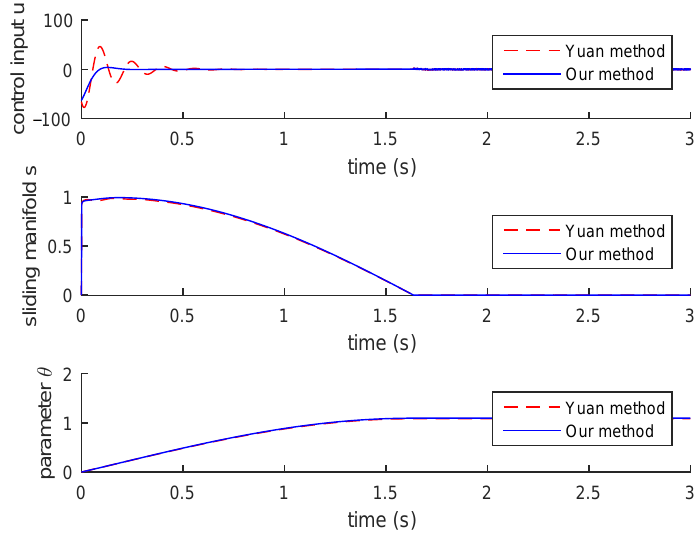
Figure 2. Control inputs and sliding manifolds in Example